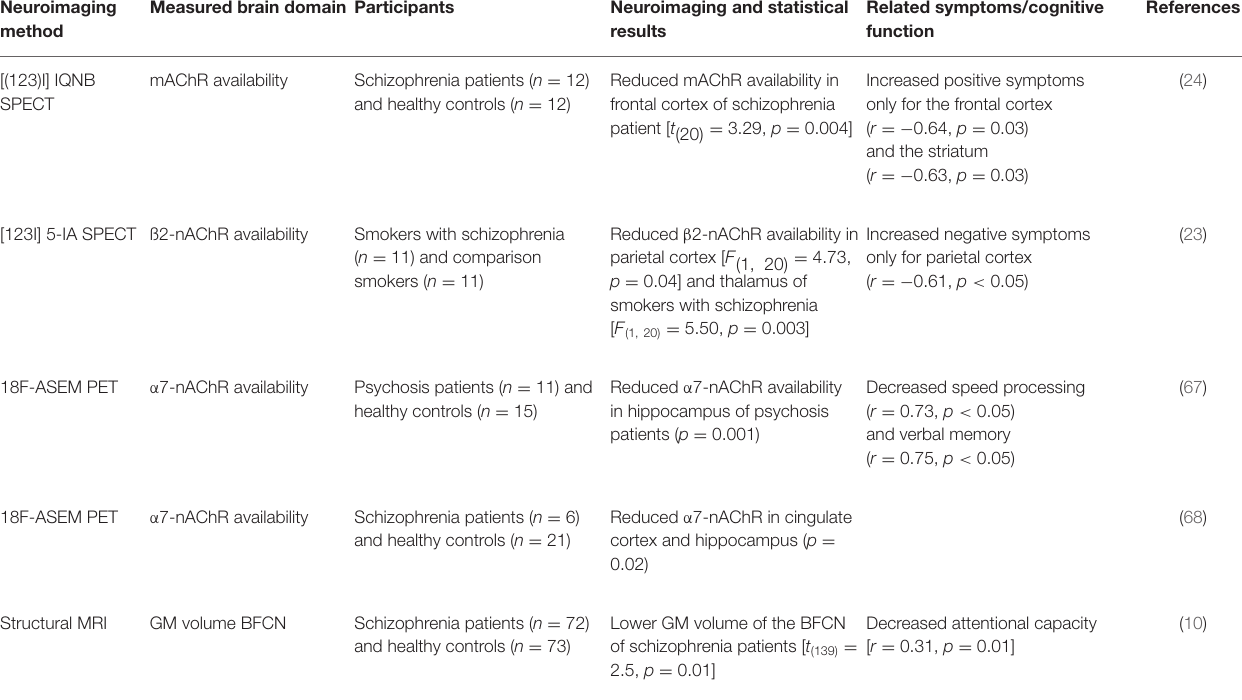
TABLE 1 | In vivo neuroimaging studies demonstrating cholinergic system alterations in psychotic disorders. Neuroimaging Measured brain domain method